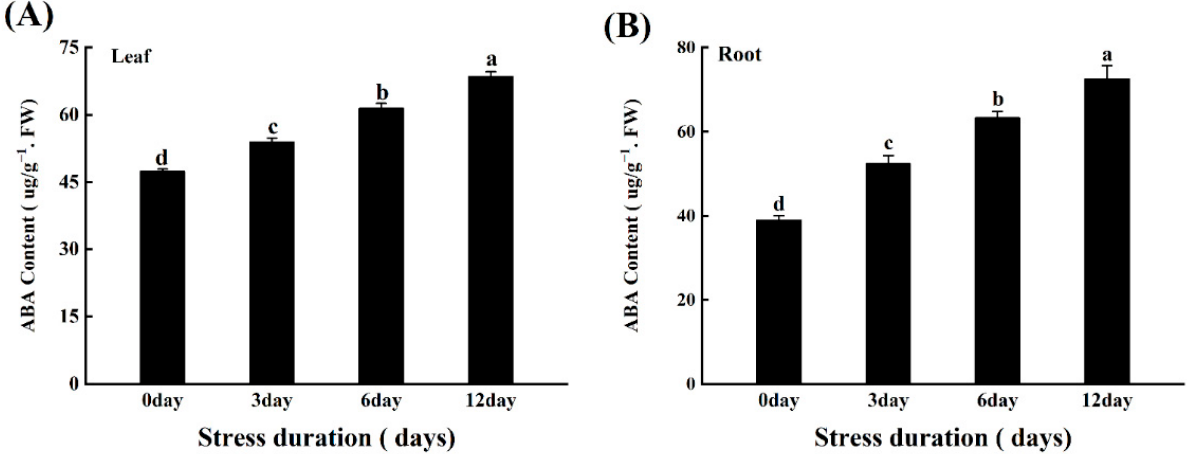
Figure 10. Effects of salt stress on Abscisic Acid in leaves ( A ) and roots ( B ) of tomato seedlings. Data was recorded after 12 days of growing tomato seedlings under control and salt stress for 12 days. Values are mean ± SD (Standard Deviation) of three replications. Different letters indicate significant differences at p ≤ 0.05 (Tukey’s HSD test).